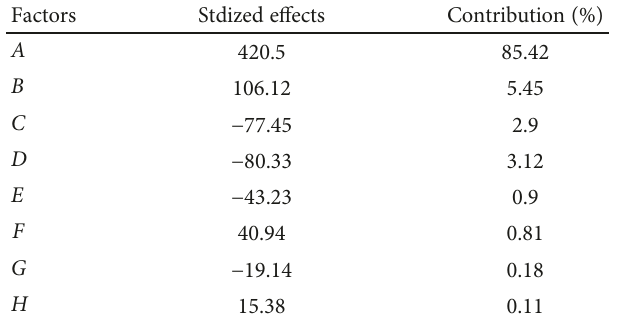
Table 4: E ff ect of factors on